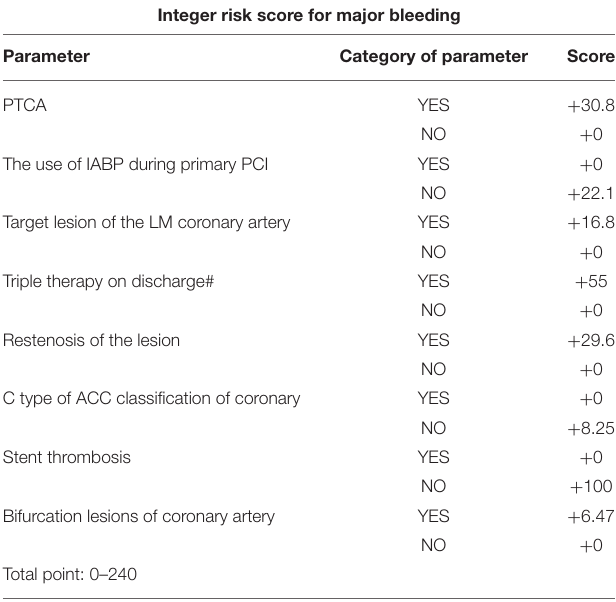
TABLE 3.1 | Integer risk score for major bleeding.